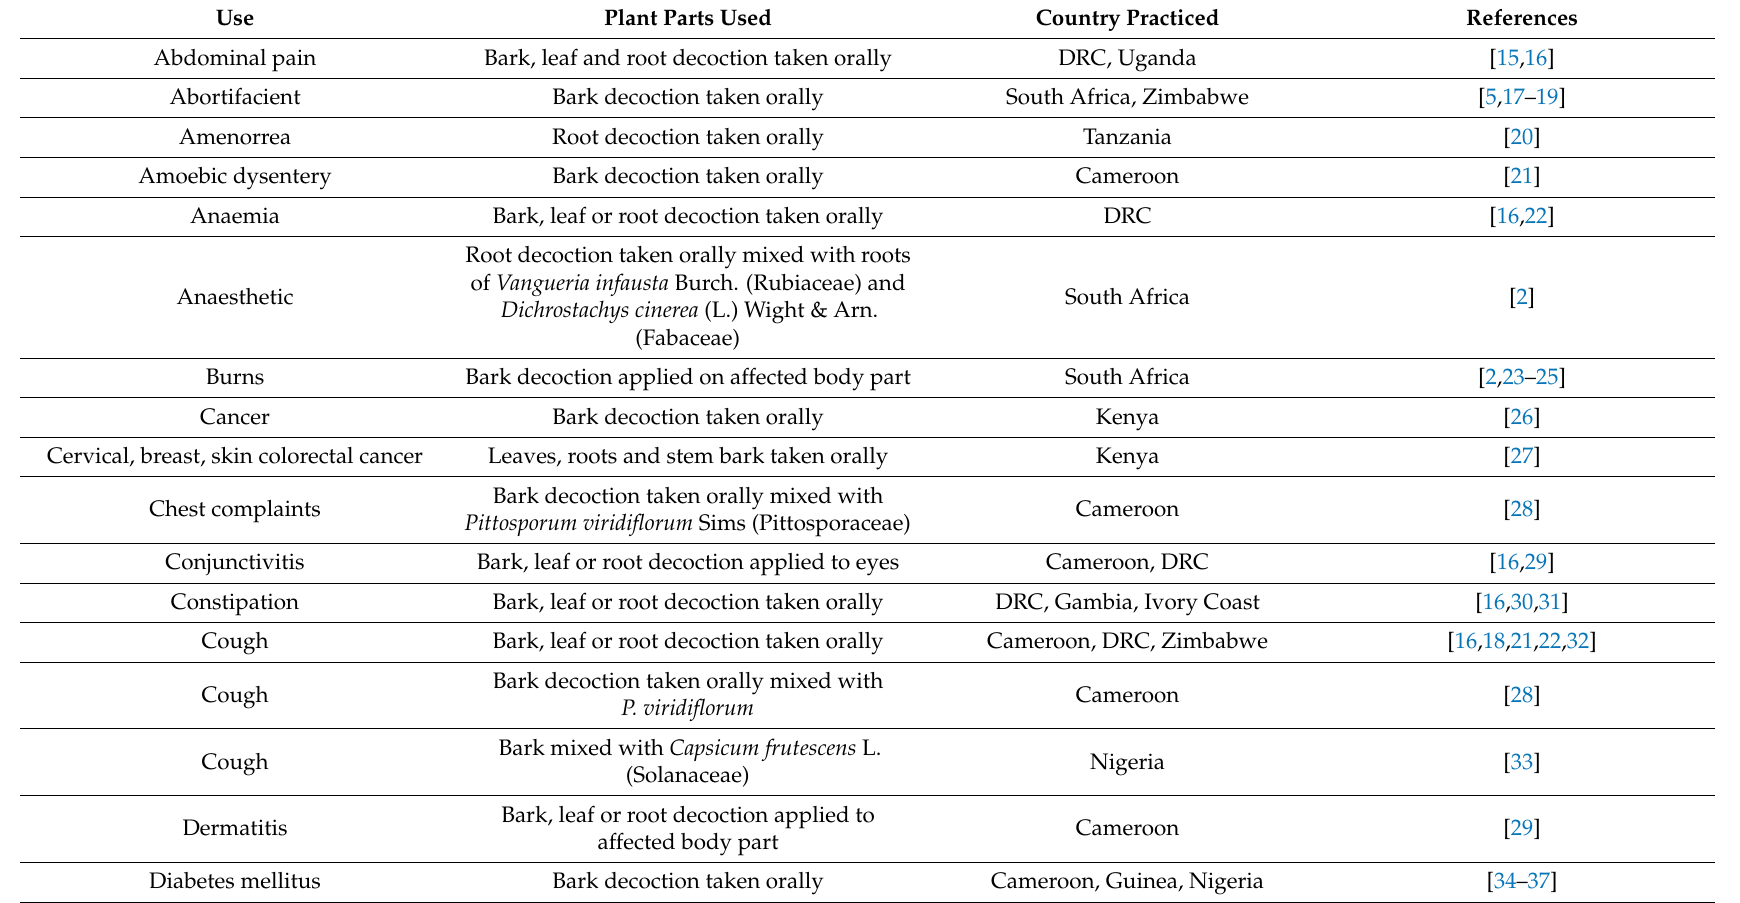
Table 1. Ethnomedicinal uses of B. micrantha in tropical